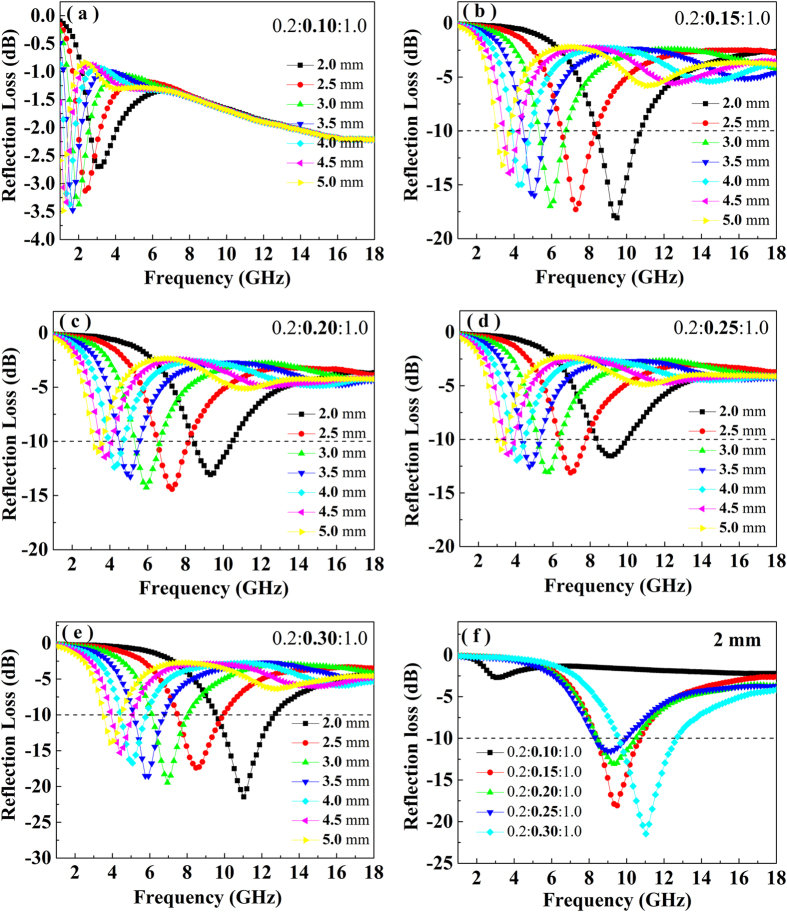
Microwave reflection loss (RL) curves of the BFTO/MCNTs/P3MT composites of (a) 0.2:0.10:1.0, (b) 0.2:0.15:1.0, (c) 0.2:0.20:1.0, (d) 0.2:0.25:1.0, (e) 0.2:0.30:1.0 with different thicknesses in the frequency range of 1.0–18.0 GHz; (f) Microwave reflection loss (RL) curves of the BFTO/MCNTs/P3MT composites with a thickness of 2.0 mm in the frequency range of 1.0–18.0 GHz.